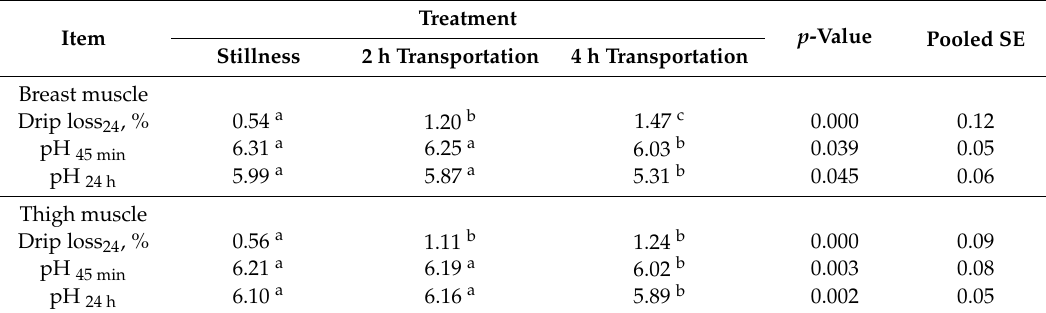
Table 3. E ff ect of di ff erent transportation treatments on drip loss and pH in broiler muscle.